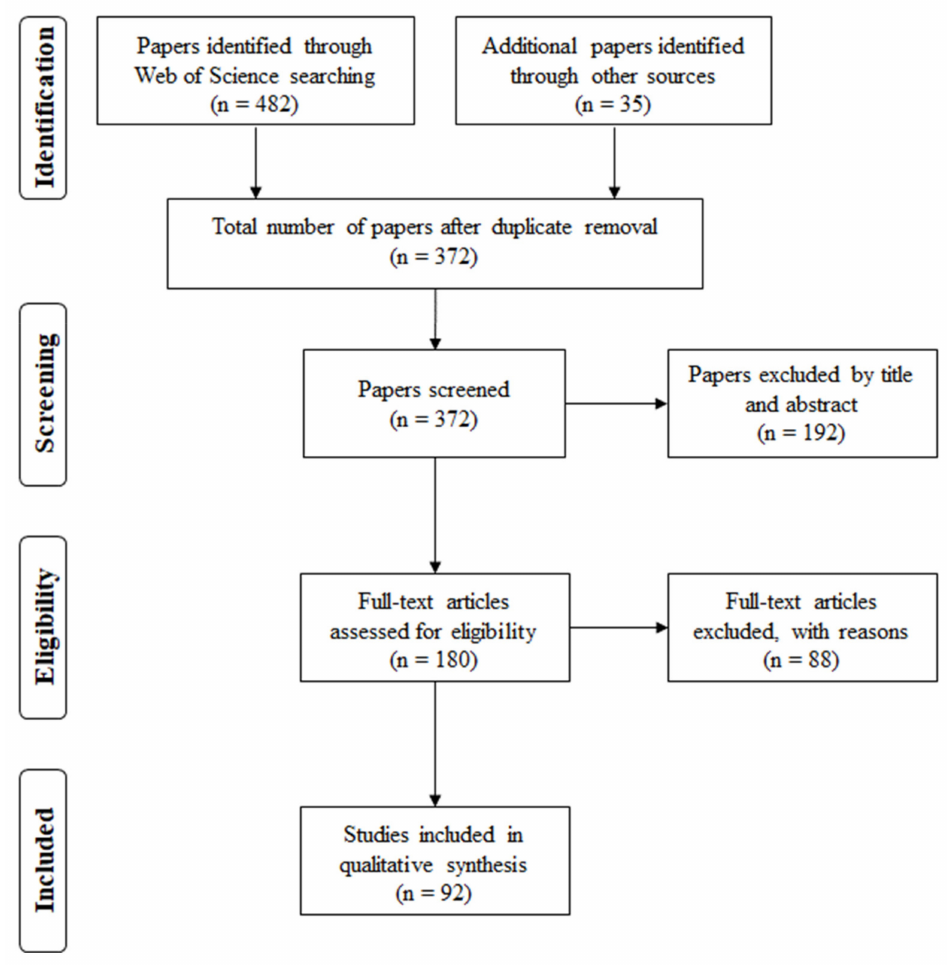
Figure 1. Diagram describing the study selection